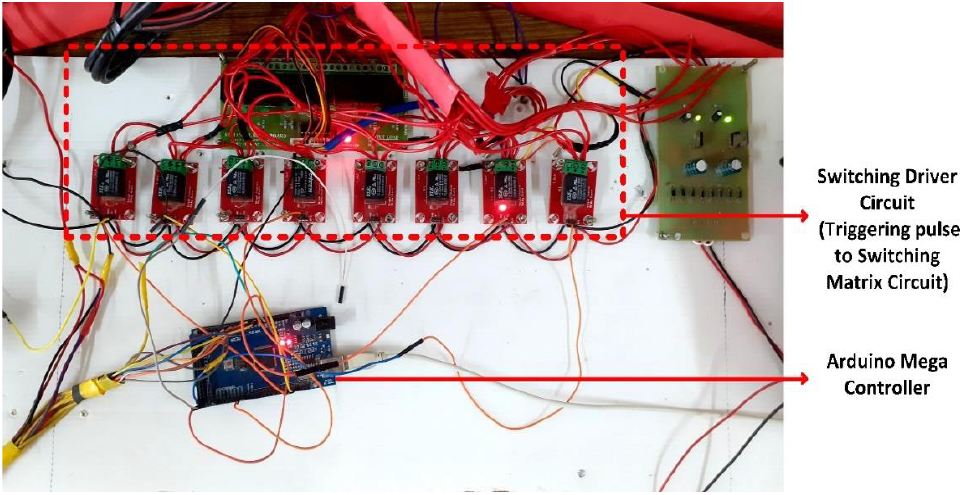
Figure 8. Photograph of switching driver circuit.